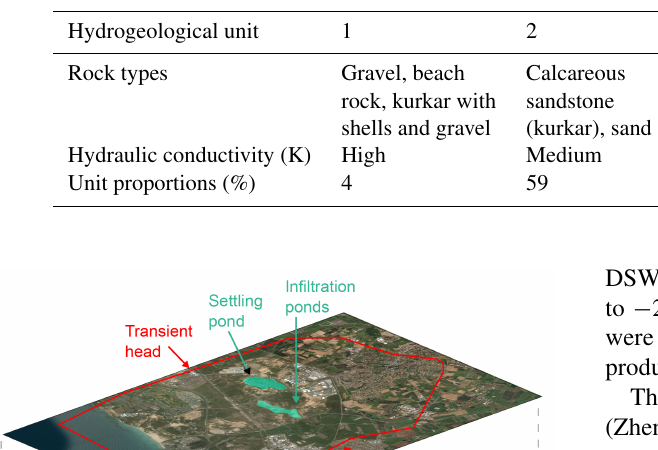
Table 1. Major rock types in the study area grouped into four hydrogeological units.